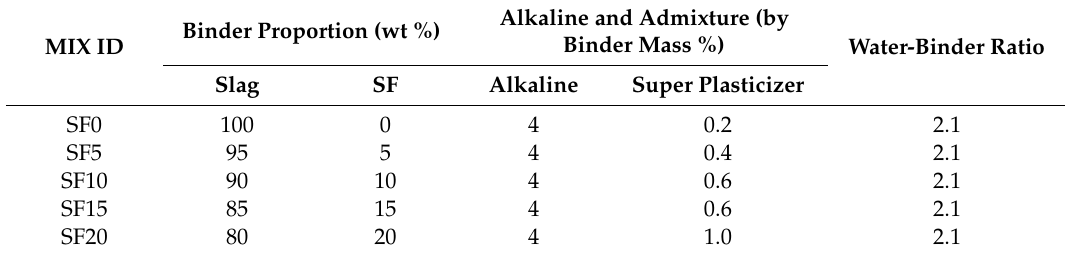
Table 2. Details of the mixture